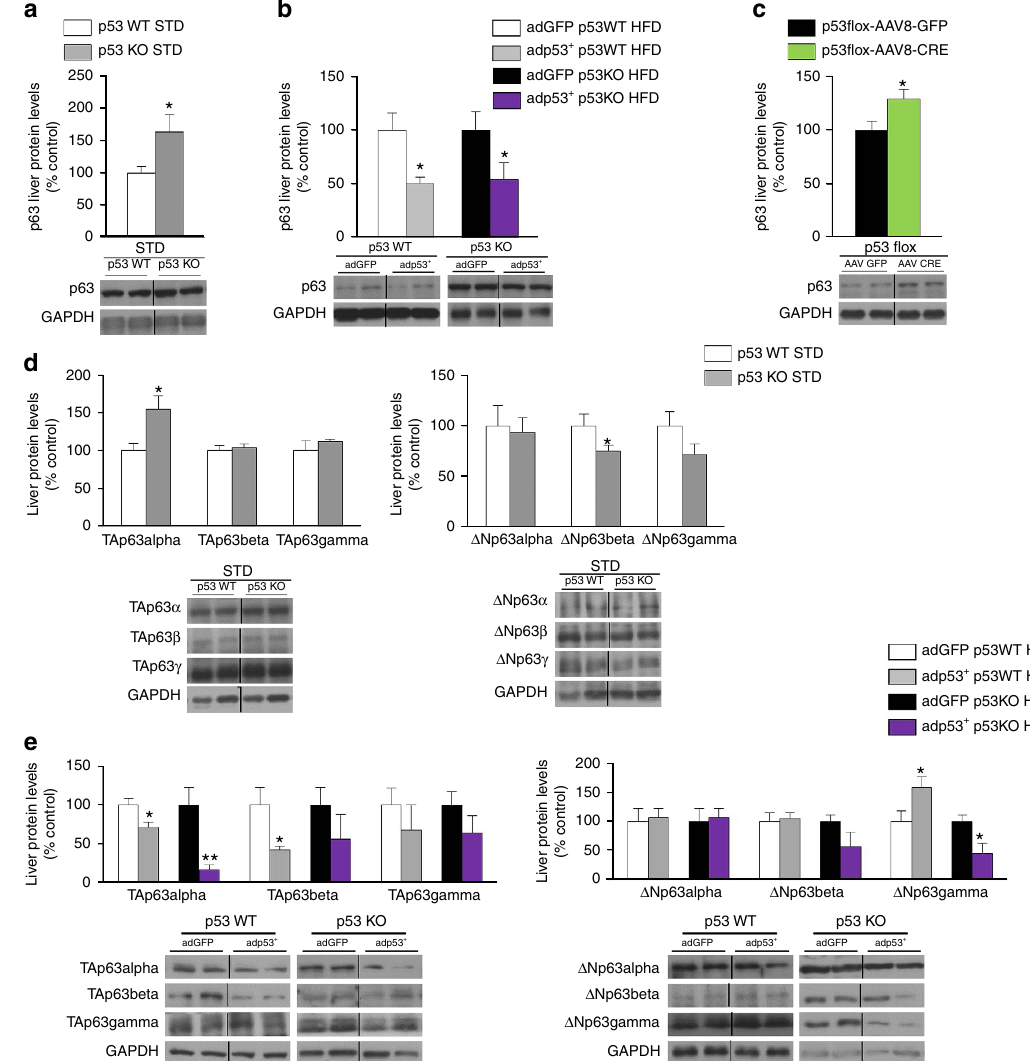
Figure 3 | p53 modulates p63 in the liver. ( a ) p63 protein levels in WTand p53 null mice fed a standard diet ( n ¼ 7 per group). ( b ) p63 liver protein levels in WTand p53 null mice fed a high fat diet injected with p53 dominant positive adenovirus and GFP ( n ¼ 5 GFP and 4 p53 in both WTand p53 null mice). ( c ) p63 liver protein levels in p53 floxed mice injected with either AAV8-GFP or AAV8-CRE ( n ¼ 7 per group). ( d ) Protein levels of TAp63 and D Np63 isoforms in the liver of WTand p53 null mice fed a standard diet. ( e ) Protein levels of TAp63 and D Np63 isoforms in the liver of WTand p53 null mice fed a high fat diet injected with p53 dominant positive adenovirus and GFP. GAPDH was used to normalize protein levels. Dividing lines indicate splicings in the same gel. Uncropped blots of this Figure accompanied by the location of molecular weight markers are shown in Supplementary Fig. 12. Data are presented as mean ± standard error mean (s.e.m.). Statistical significance, * P o 0.05 and ** P o 0.01, was tested using two-tailed Student t